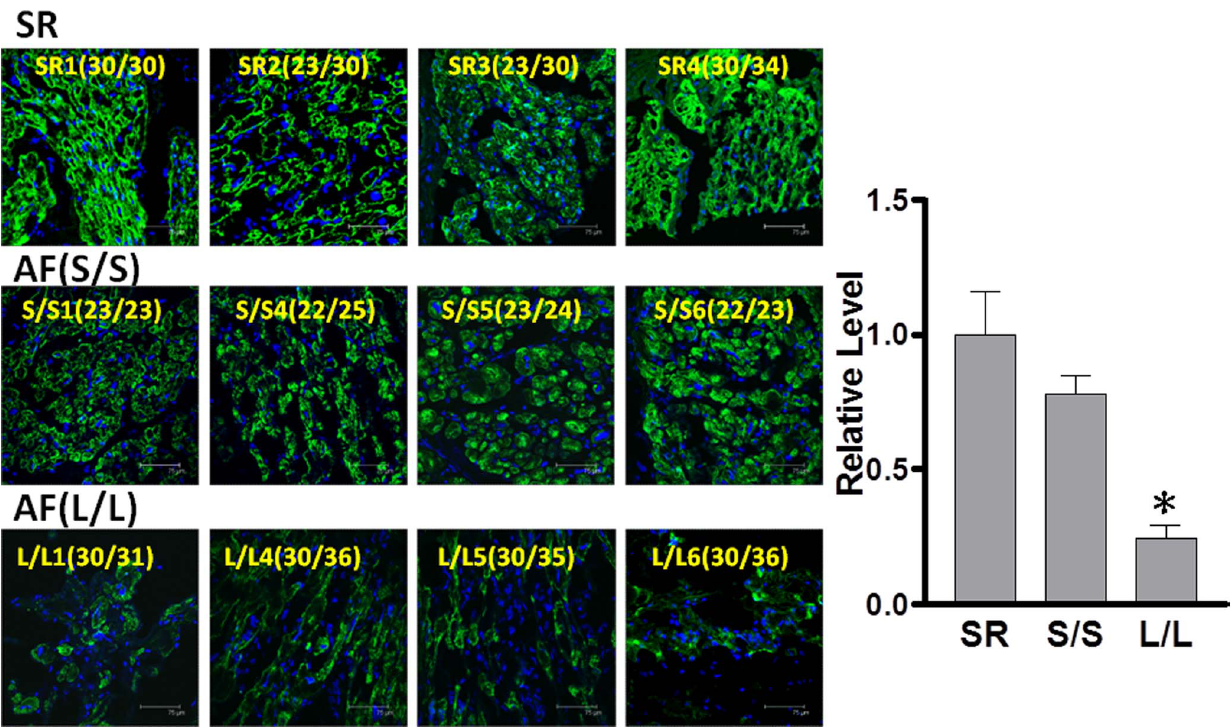
Figure 4. Association of the GT-repeat length polymorphism with myofibril degradation in AF tissues. Representative confocal images show myosin degradation in the atria of 8 AF patients and 4 controls (sinus rhythm subjects [SR], left). Relative intensity of MHC in the a -actin- expressing area was quantified (right). Data are expressed as mean 6 SE. P , 0.05; *: the different symbol represents the significant difference among